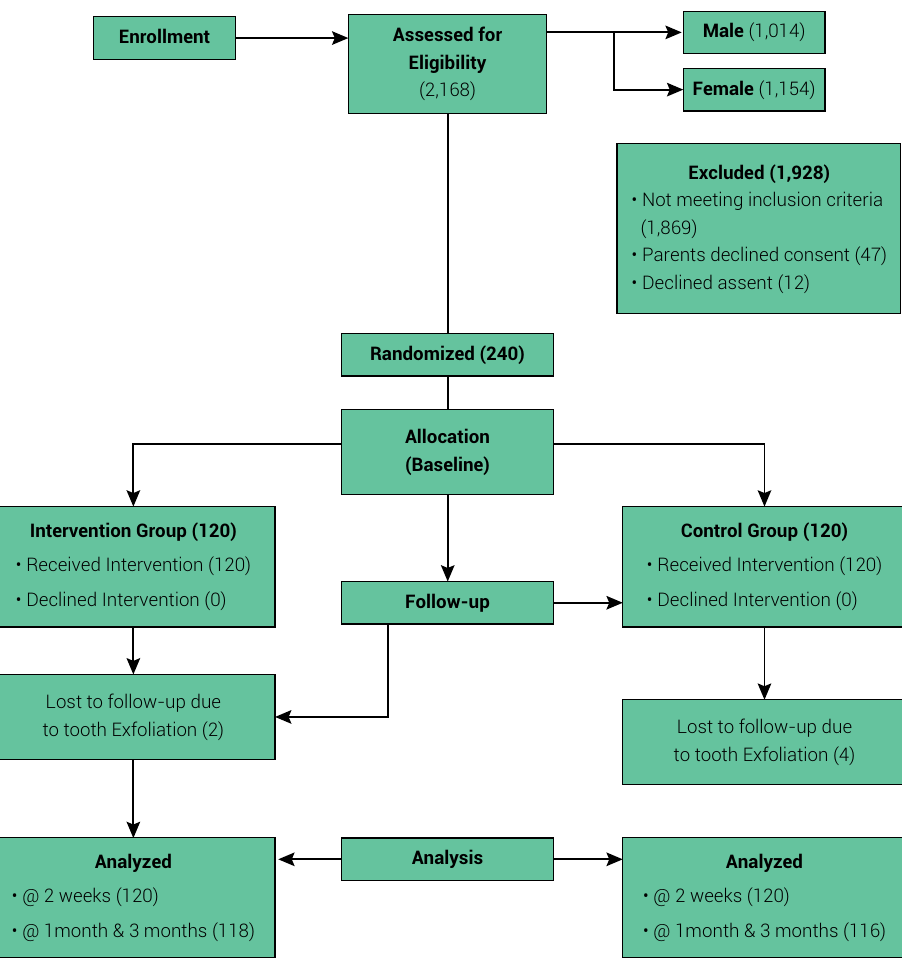
Figure 1. Participants